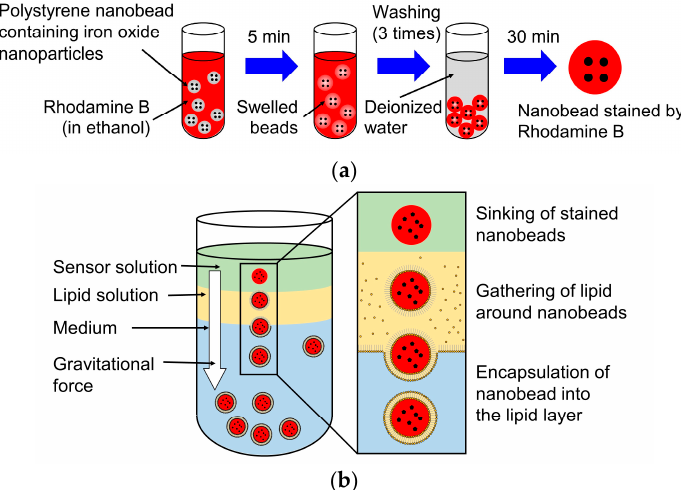
Figure 4. Fabrication process of the nanosensor. ( a ) Stain of the polystyrene nanobead by hodamine B; ( b ) Encapsulation of the fluorescence polystyrene nanobead into the lipid layer with 1,3,3-trimethylindolino-6 (cid:48) -nitrobenzopyrylospiran (SP).